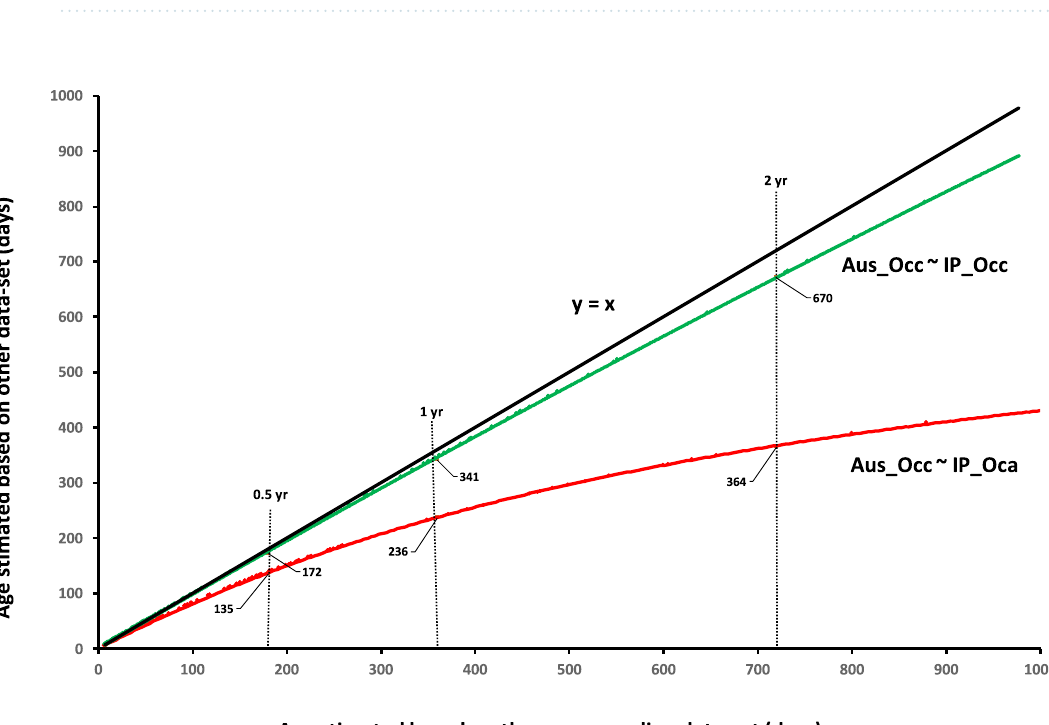
Figure 3. Age estimates for European rabbits calculated with the parameters obtained with the curve corresponding to each Iberian subspecies’ dataset and the Australian or subspecies counterpart. The black line corresponds to the linear regression ( y = 1 x ). Occ: Oryctolagus cuniculus cuniculus ; Oca: Oryctolagus cuniculus algirus ; Aus: Australia; IP: Iberian